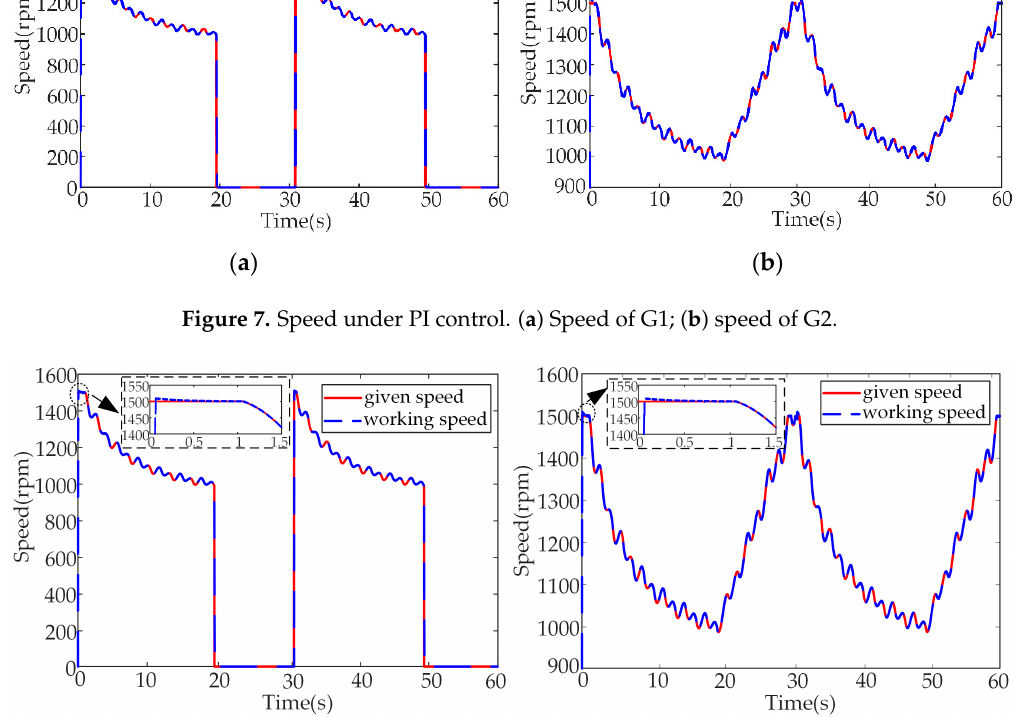
Figure 8. Speed under SMC control. ( a ) Speed of G1; ( b ) speed of G2.